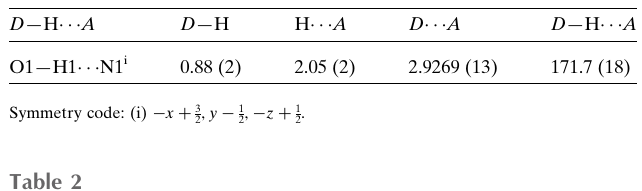
Table 2 Experimental details.